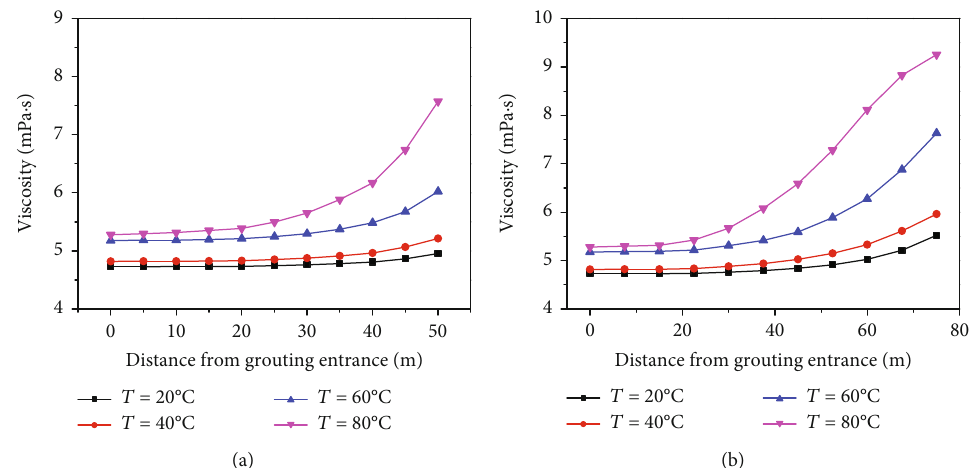
Figure 9: The dynamic viscosity of the grout reaching di ff erent distances in the fracture with di ff erent lengths when temperature fi eld is ignored: (a) 50 m and (b) 75m.